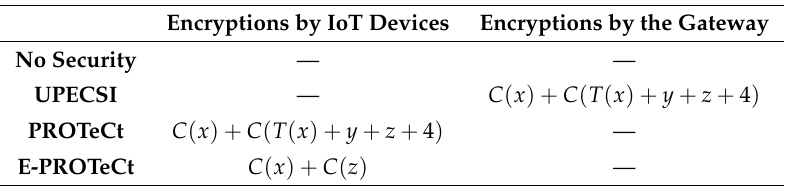
Table 2. Cryptographic operations by IoT devices and the gateway, considering x bytes of data, an access token of y bytes and a hash of z bytes.